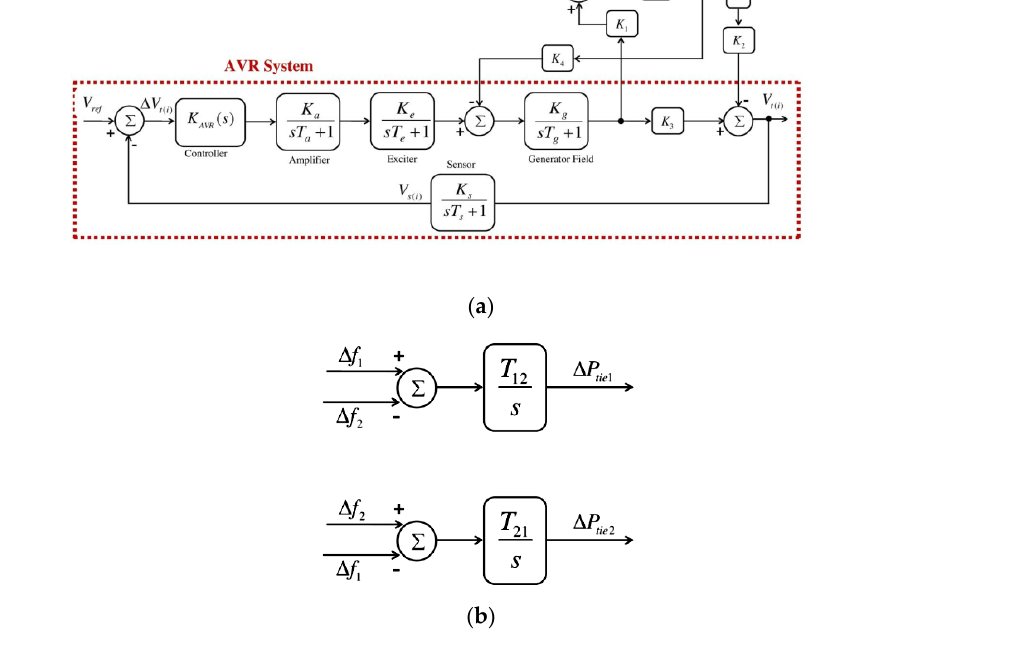
Figure 1. ( a ) Model of IPS with combined AVR-LFC. ( b ) Tie-ine connection for